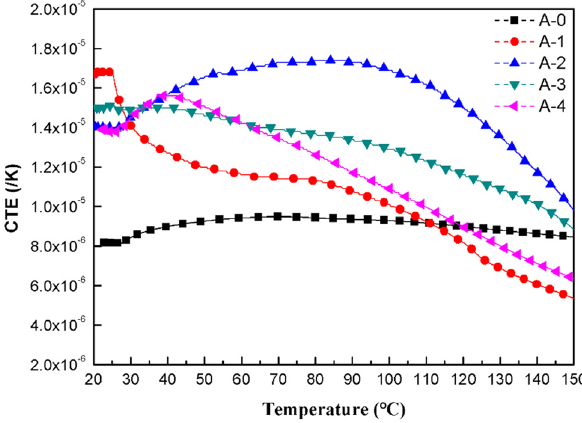
Figure 8: CTE curve of composites.